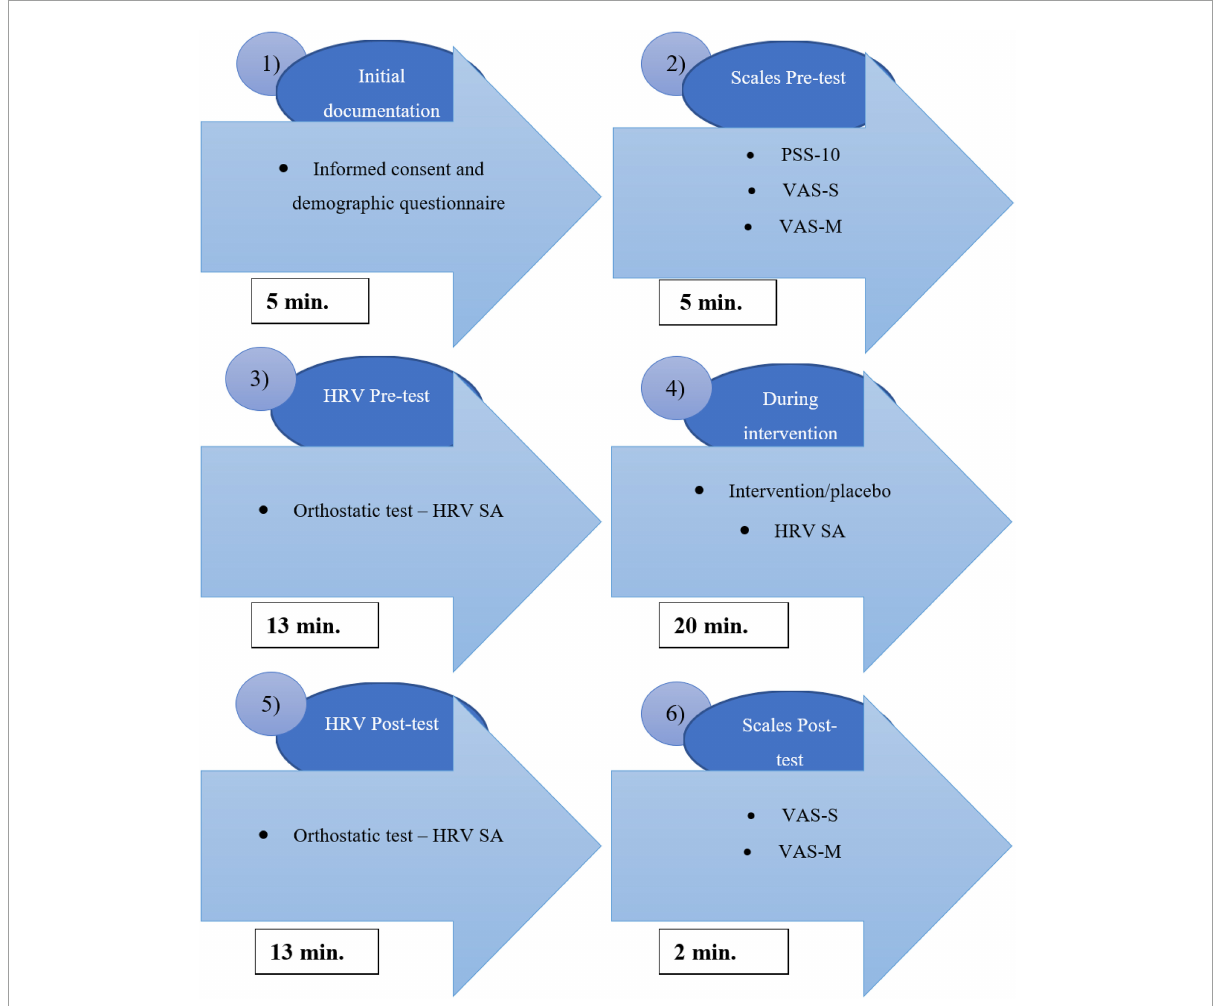
FIGURE2 The research experiment procedure (PSS-10, perceived stress scale questionnaire; VAS-S, visual analogue scale for stress; VAS-M, visual analogue scale for muscle relaxation; HRV SA, spectral analysis of heart rate variability).